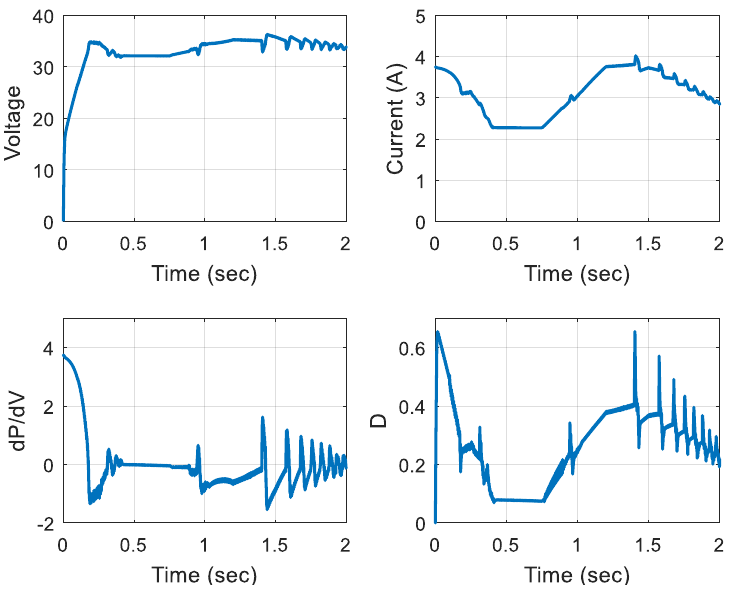
Figure 16. Voltage, current, dP/dV, and D for a combination of step and ramp values of irradiance at 25 ℃.